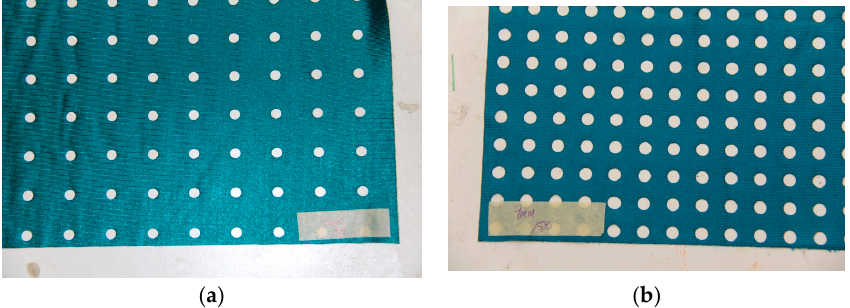
Figure 2. ( a ) Knit fabric sample with 9 mm holes and 5% openness; ( b ) Knit fabric sample with 9 mm holes and 15% openness (Note: magnification ratio differs between